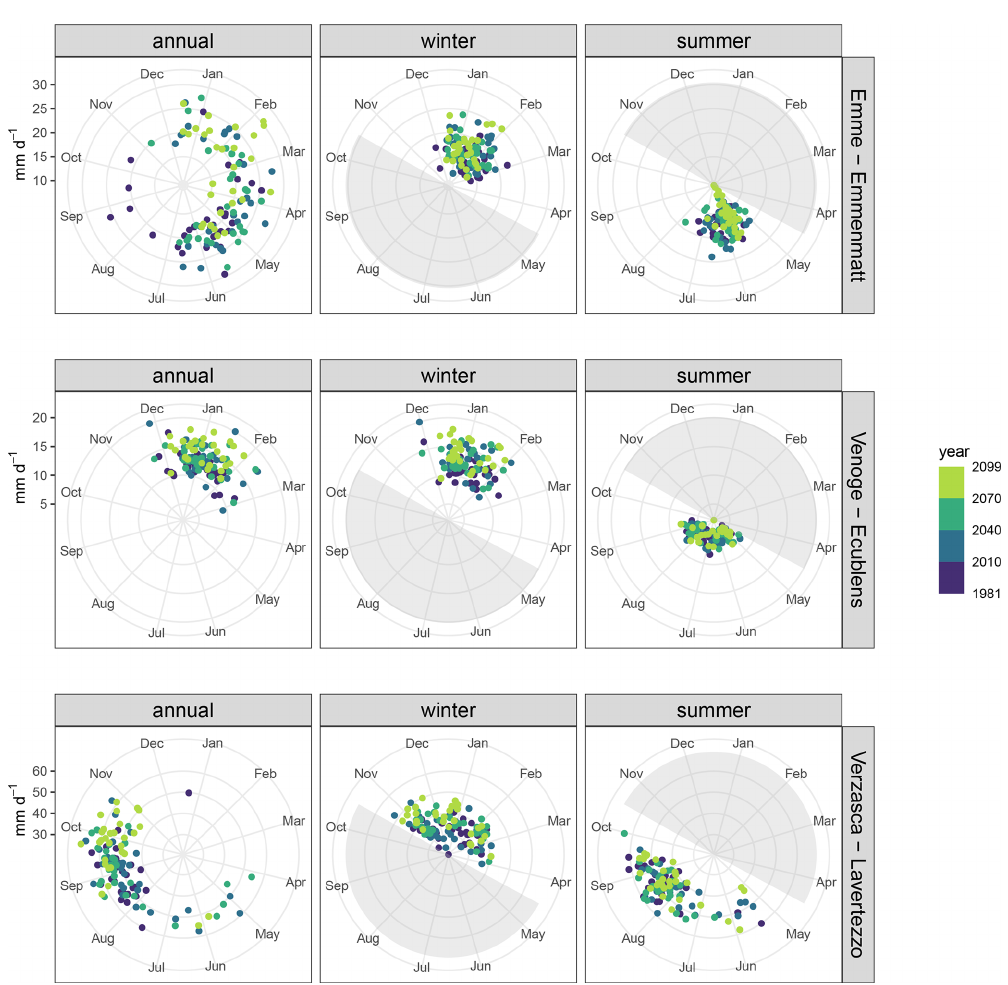
Figure 8. Multimodel median of magnitude and seasonality of high flows and seasonal high flows in lower-lying catchments: Emme (top row panels), Venoge (middle row panels), and Verzasca (bottom row